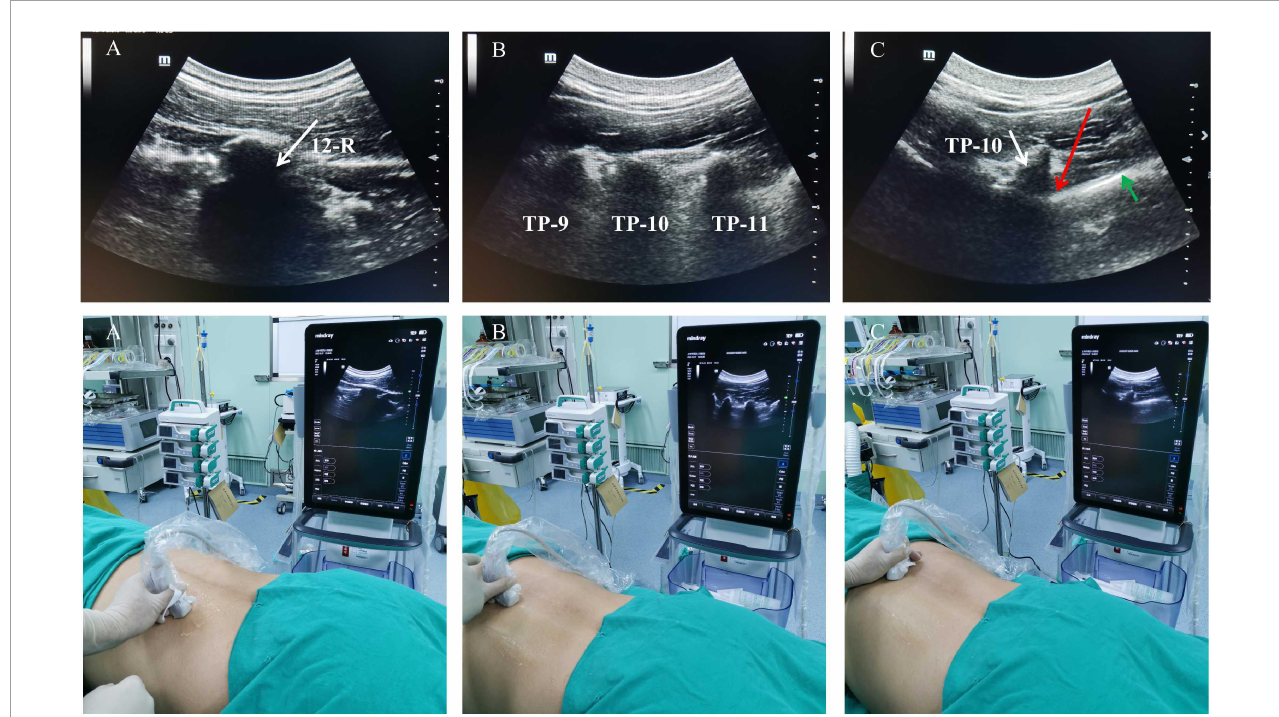
FIGURE1 Illustration of the step-wise technique for paravertebral block. (A) The probe is moved cephalad to determine the position of the 12th (white arrow). (B) The probe is rotated to the sagittal plane and the transverse process of T 9 , T 10 , and T 11 is in the same visual field. (C) The probe is moved to determine the paravertebral spaces (red arrow), transverse process of T 10 and the pleura (green arrow) is identified. R, rib; TP, transverse process.